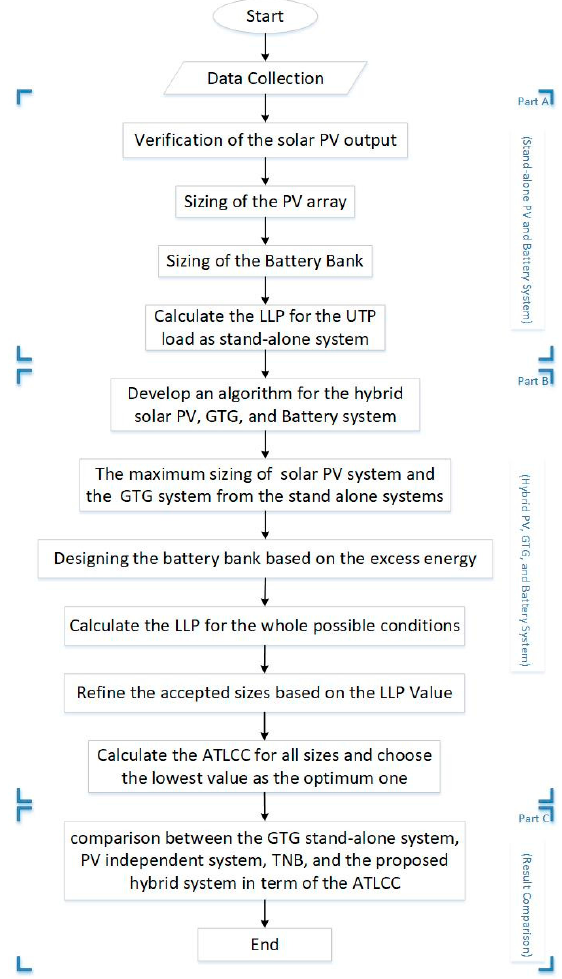
Figure 1 . Methodology flowchart . Figure 1. Methodology